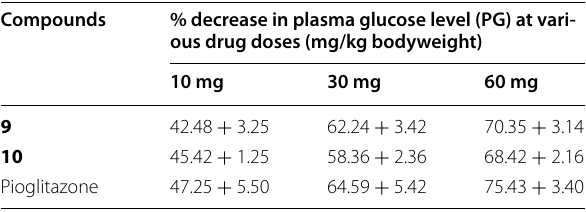
Table 5 Plasma glucose level of 3–4 at various drug doses